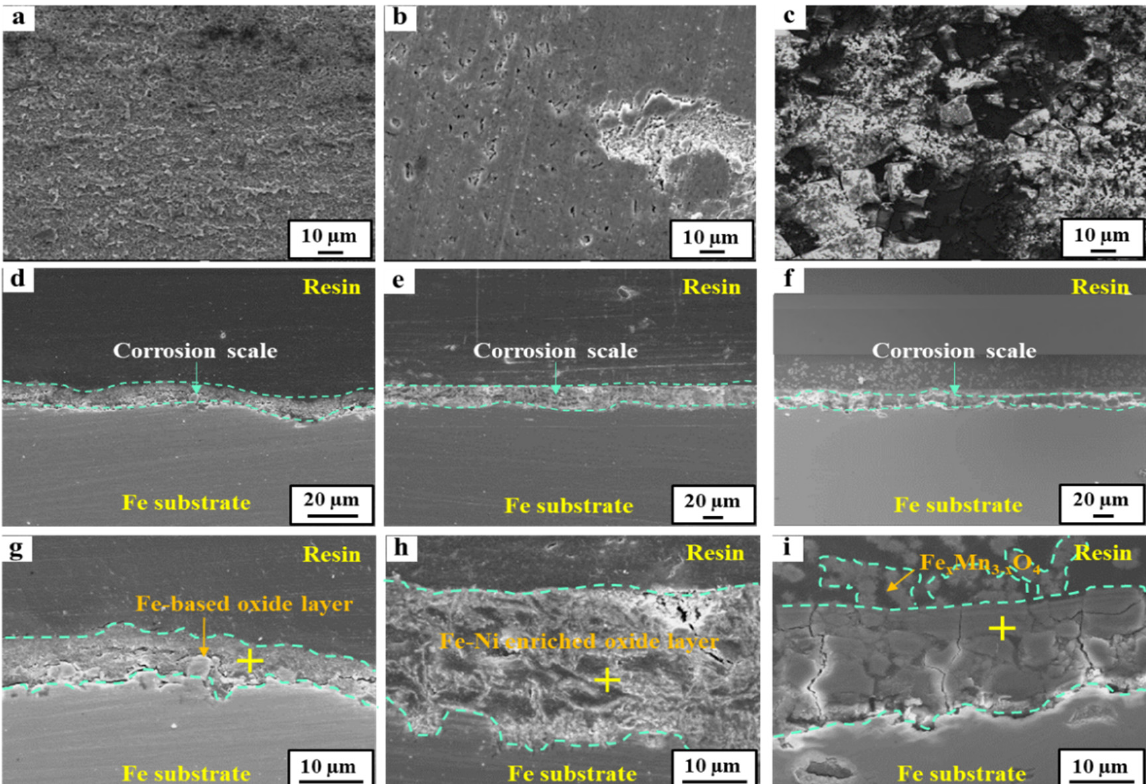
Figure 6. FE-SEM images of the tested samples immersed in an acidic solution for 28 days. ( a – c ) Surface images of APIX70, 9Ni, and 24Mn3Cr, respectively; ( d – f ) Cross-sectional images of APIX70, 9Ni, and 24Mn3Cr, respectively; ( g – i ) Magnified view of ( d – f ). Table 5. EDS quantitative analysis at each point marked on Figure 6.